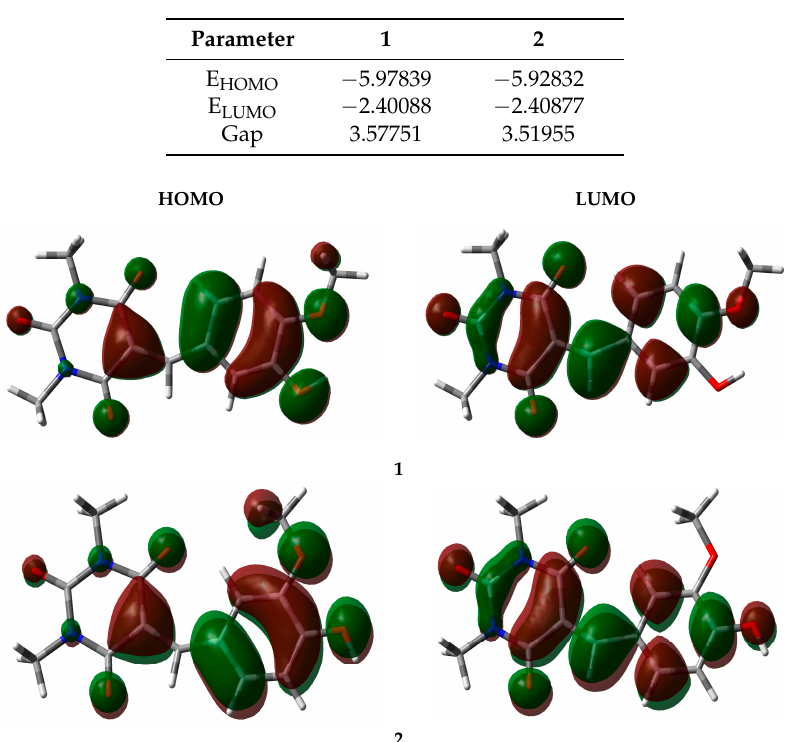
Figure 4. The frontier molecular orbitals of the studied isomers.